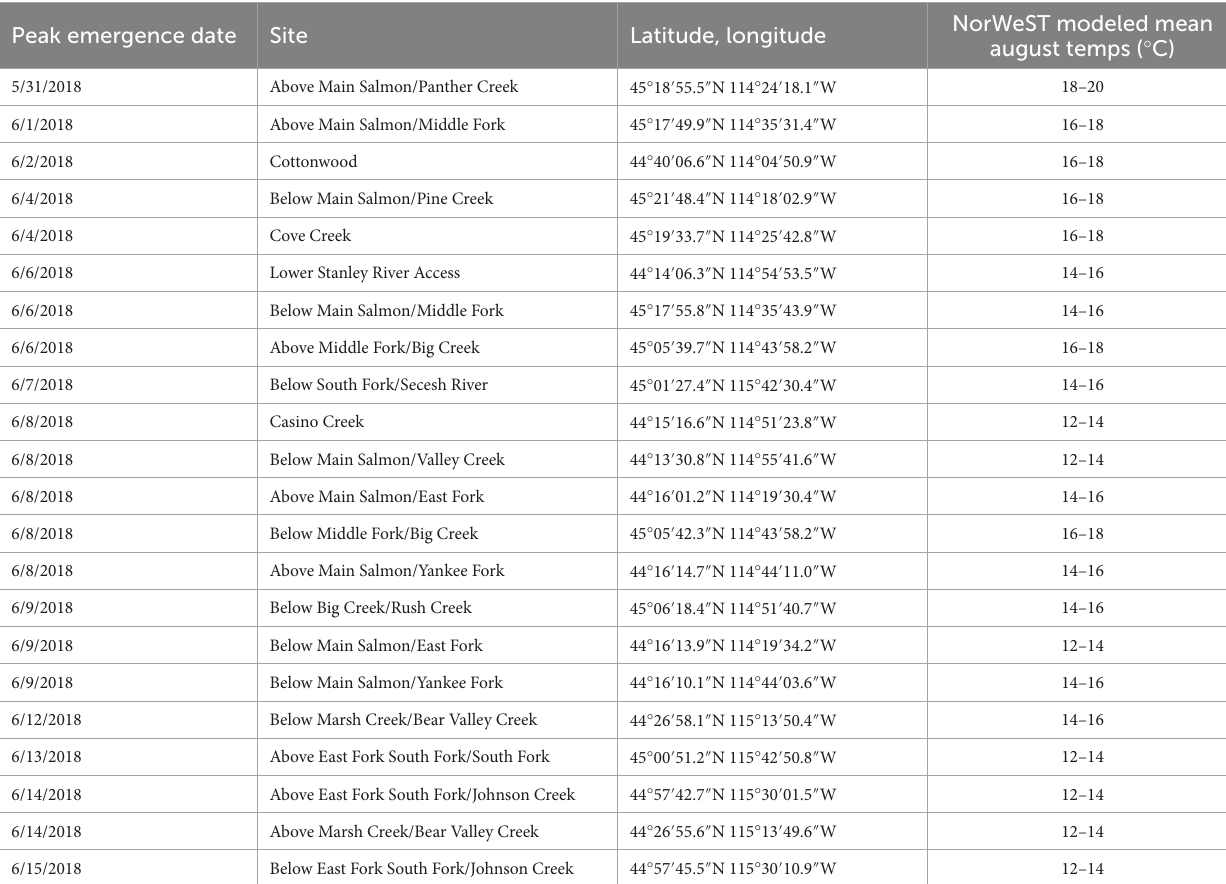
TABLE 1 Modeled NorWeST August temperatures and the date of peak emergence of salmonflies for 22 sites surveyed for timing of salmonfly emergence throughout the Salmon River Drainage, Idaho, United States. Peak emergence date